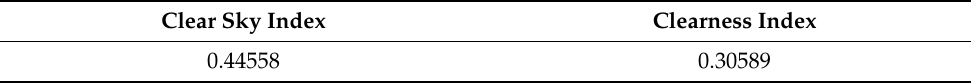
Table A1. KPSS tests: critical value = 0.216 for p -value =